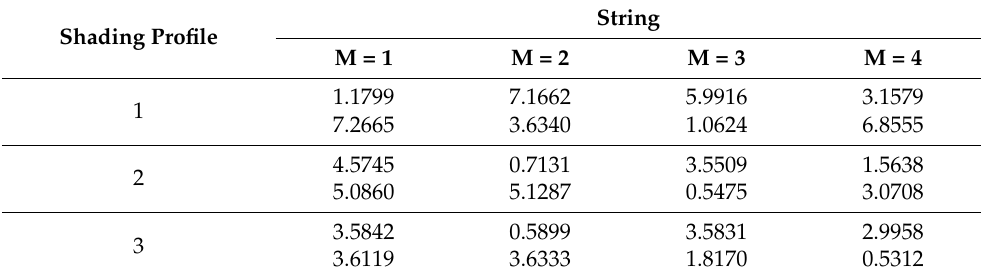
Table 2. I ph currents of the reconfigurable submodules in the array (the first two rows). Shading Profile